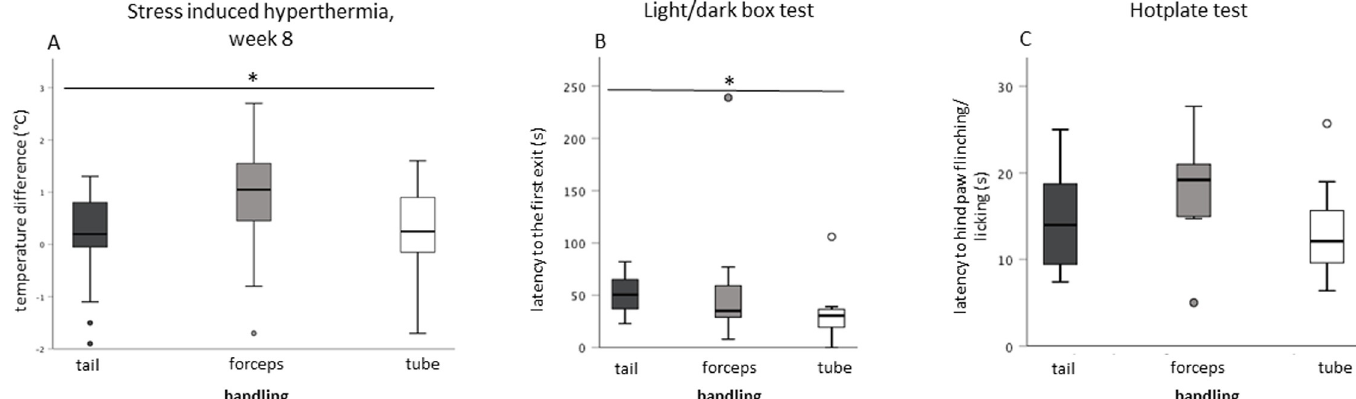
Fig 3. Handling effects. A) Stress induced hyperthermia, (cages n = 36, 24 mice/handling method). Effect of handling treatment on the SIH in 8 th week. A higher temperature difference was found for forceps-handled animals compared to tube- and tail-handled mice (p < 0.05). B) Light/dark box test, (n = 36, 12/handling method). Evaluation of anxiety behavior regarding the factor ‘handling’ in a LDB test. Tube-handled mice had diminished anxiety behavior represented by the latency to the first exit. C) Hotplate test, (n = 36, 12/handling method). Asterisks indicate the level of significance ( � p � 0.05; �� p � 0.01; ��� p � 0.001).